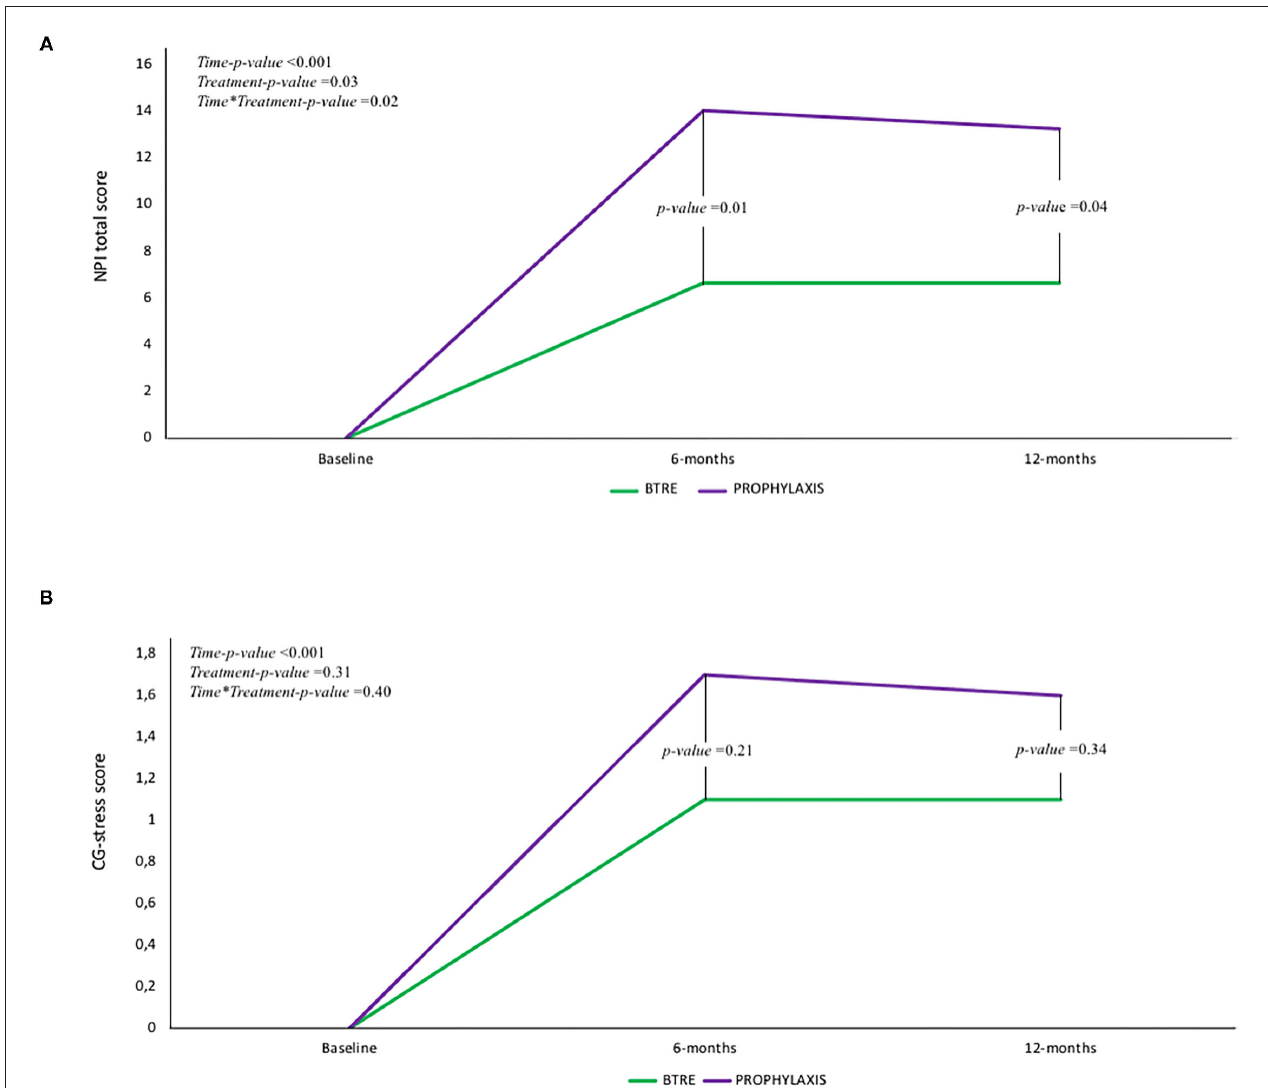
FIGURE 2 | (A) Change in Neuropsychiatric Inventory (NPI-Q) total score in the two subgroups according to time. A multiplicative effect for the interaction between group treatment for time ( p = 0.02) was observed. (B) Change in caregiver distress score (CDS) in the two subgroups according to time. For the CDS only a time-effect was observed whereas no additive or multiplicative effect was